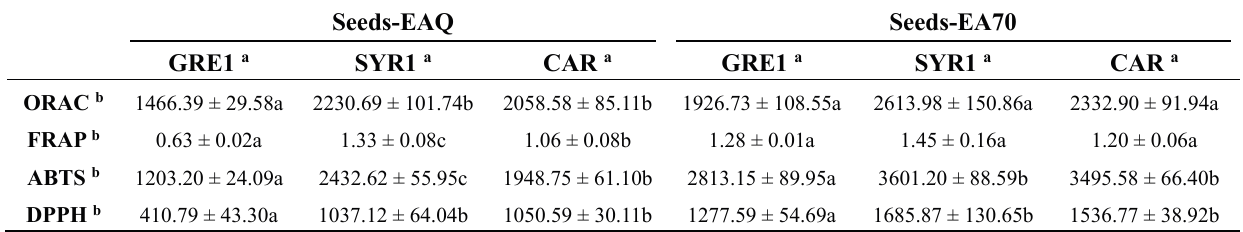
Seeds-EAQ Seeds-EA70 GRE1 a SYR1 a CAR